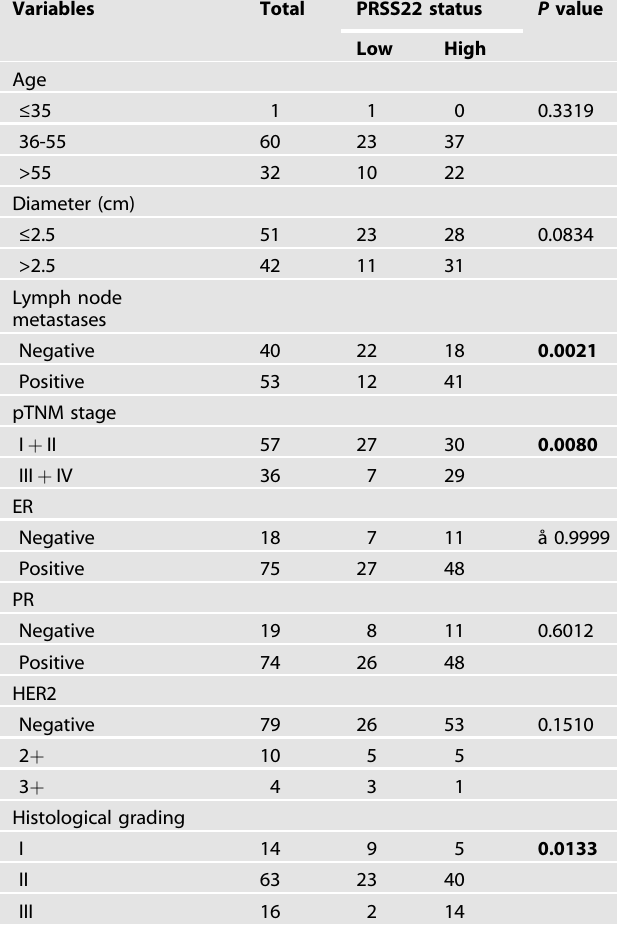
Bold values indicate statistical signi fi cance P < 0.05. nontumorous breast tissues (Fig. 1H), and upregulated in BC tissues, particularly in BC with LNM (Table 1). Compared with ductal carcinoma in situ (DCIS), PRSS22 expression signi fi cantly increased in invasive ductal carcinoma (IDC) of the breast (Fig. 1I). These results indicated that PRSS22 expression was up-regulated gradually from nontumorous breast tissues to BC tissues without LNM to BC tissues with LNM (Table 1 and Fig. 1D – G). Correlation analysis showed that